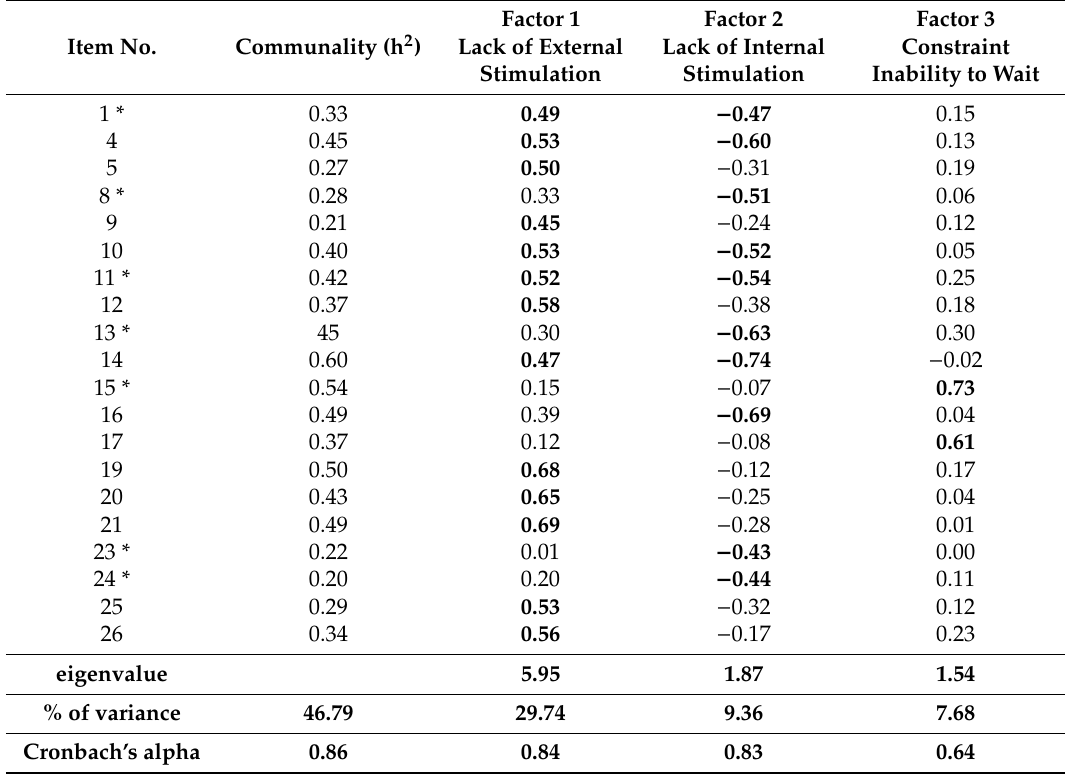
Table 2. Exploratory factor analyses (EFA) communalities and factor loadings after the oblique rotation of the shortened